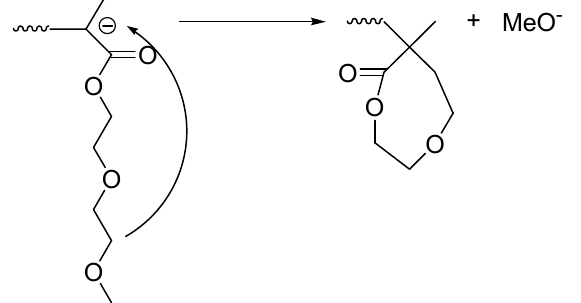
Figure 8. Potential termination of the chain propagation by the reaction of the living chain end with its own side-chain with the formation of 8-member ring.